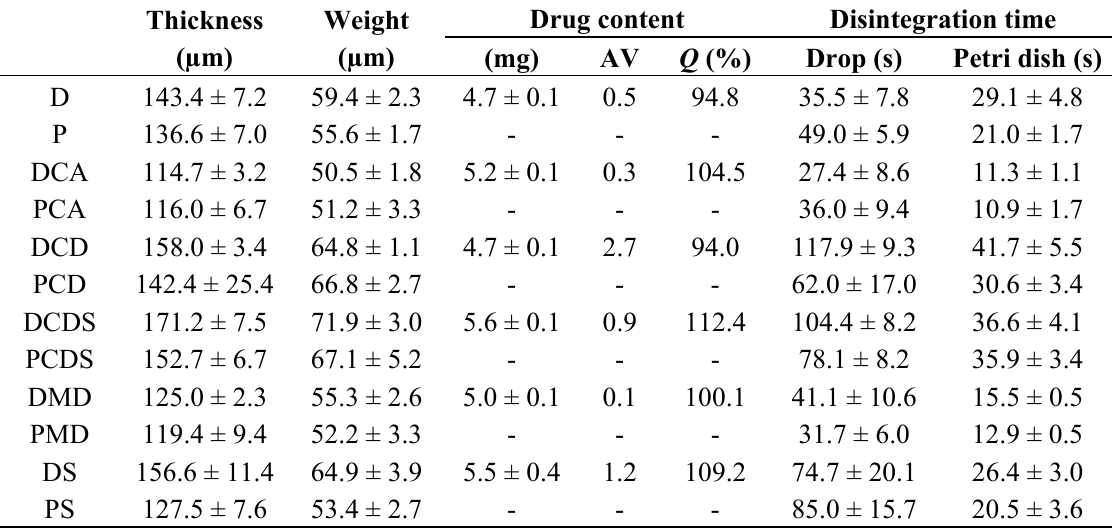
Table 5. Properties of prepared orodispersible films: thickness, weight, drug content and disintegration